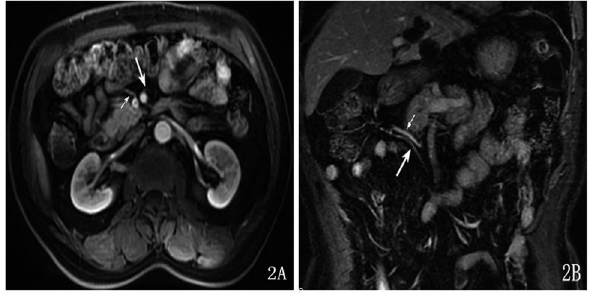
Figure 2. The middle colic artery showed on the axial enhancement image (A, long arrow) and on the coronal enhancement image (B, long arrow). The middle colic vein was shown on the axial enhancement image (A, short arrow) and on the coronal enhancement image (B, short arrow).